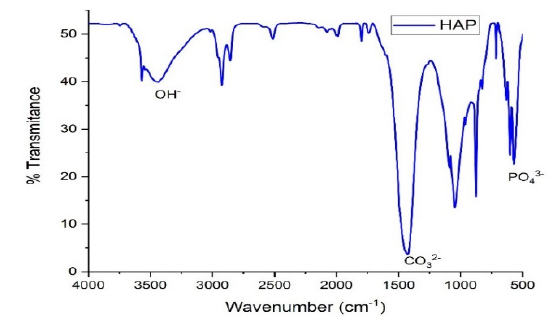
Fig. 3: IR spectrum of prepared HAP